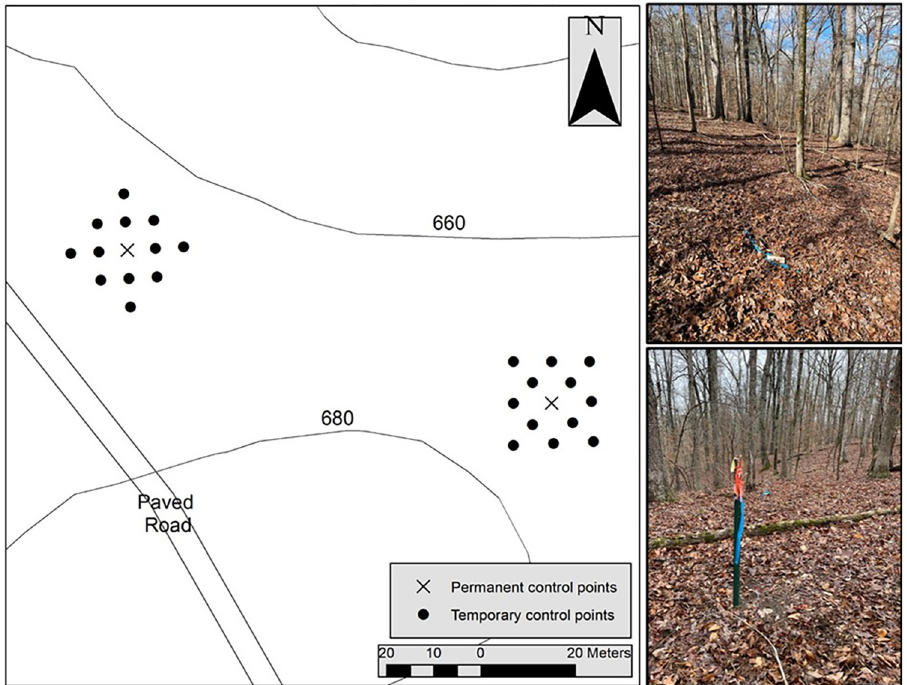
Fig 1. The study location of a portion of the GPS Test Site in Athens, Georgia (USA). The temporary control points were placed on a 6 m grid around a permanent control point.